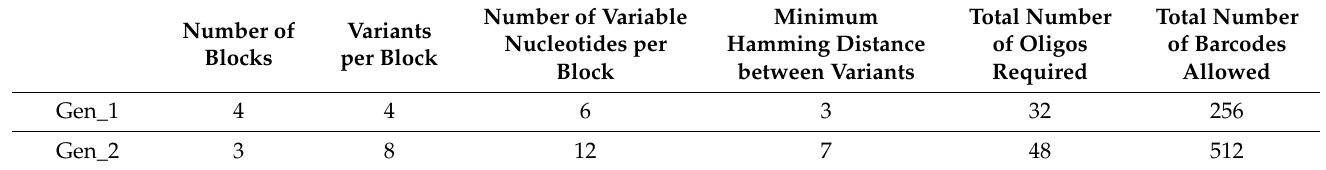
Table 1. Modular barcode library parameters.